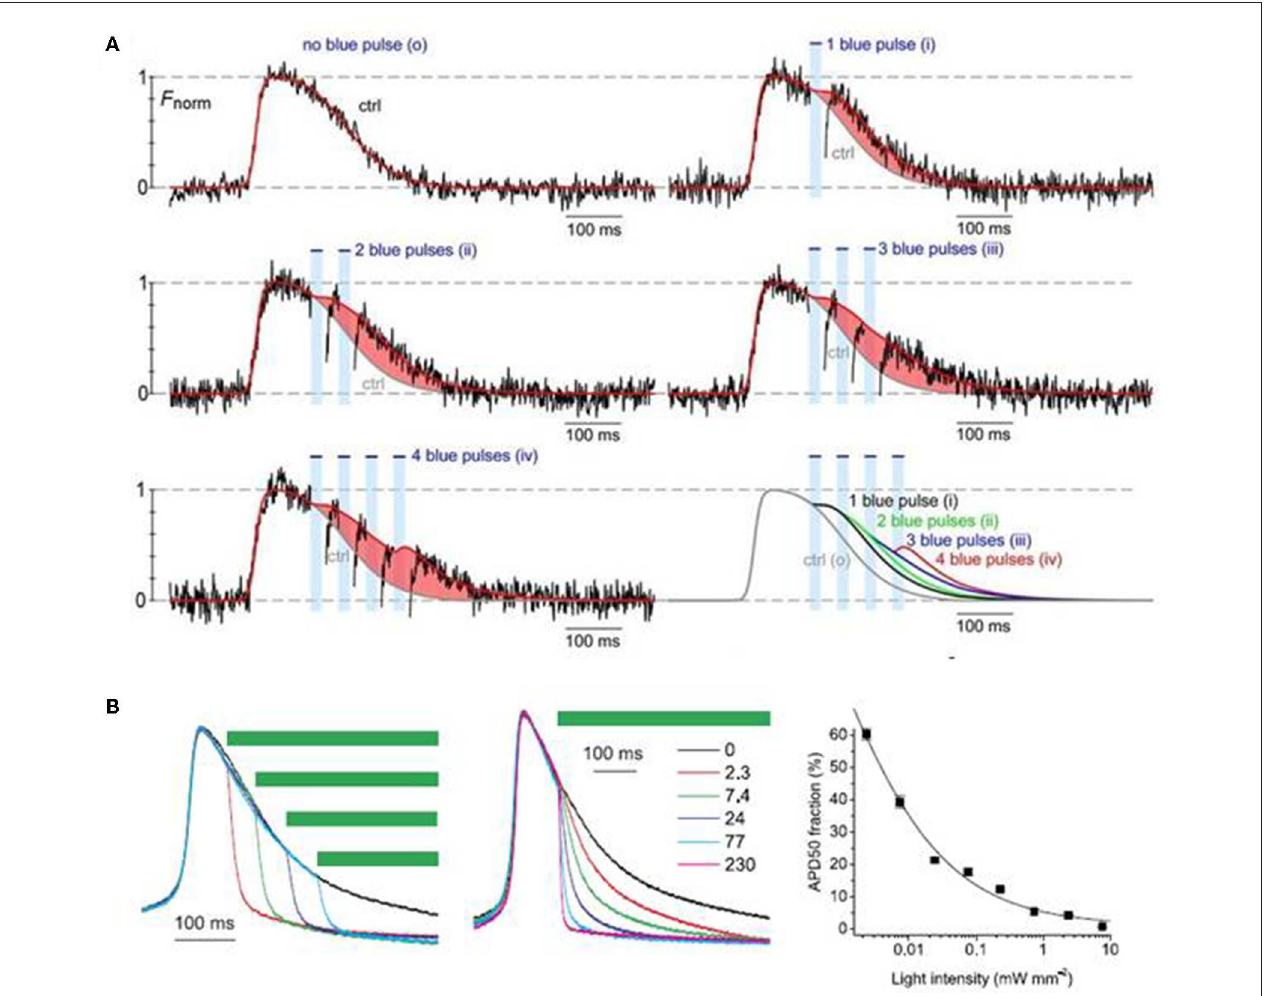
FIGURE 4 | Optogenetic manipulation of action potential duration using light stimuli of an appropriate wavelength. Action potential duration of ChR2-sensitized cardiomyocytes can be prolonged upon application of blue light pulses during the repolarization phase of the cells and the increment in action potential duration is dependent on the number of light pulses (A) . On the contrary, action potential of cardiomyocytes expressing GtACRs, an anion channelrhodopsin, can be shorted using green light pulses (510nm), where the action potential shortening is dependent both on the instance of illumination and light intensity (B) . Reproduced with permission from Park et al. (2014) and Govorunova et al.